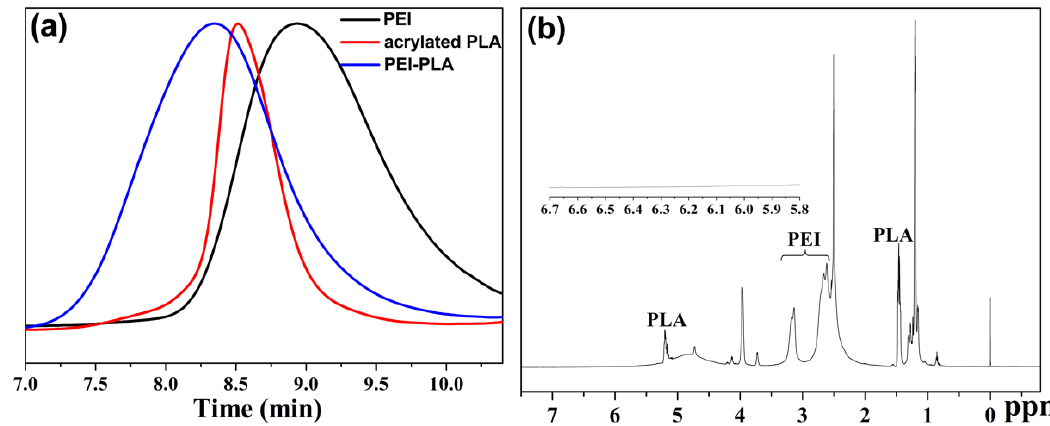
Figure 2. ( a ) GPC chromatograms of PEI, acrylated PLA and PEI-PLA copolymer; ( b ) 1 H NMR spectrum of PEI-PLA copolymer in DMSO-d6, the inset represents magni fi cation of 5.8 − 6.7 ppm.